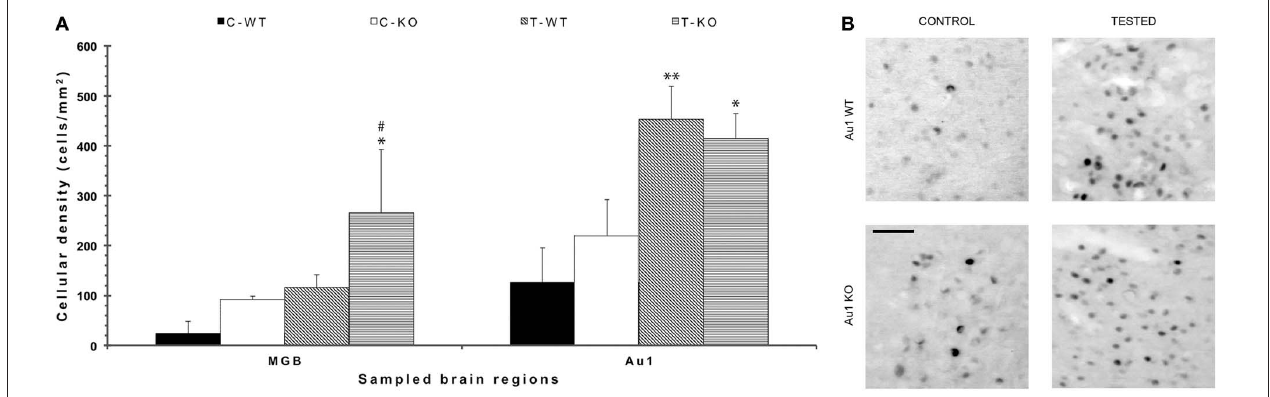
mice with similar treatment (tested or not tested). Three-way ANOVA followed by LSD test. (B) Photomicrographs of FosB/ (cid:2) FosB-immunopositive cell nuclei in Au1. Scale bar: 25 μ m. C-WT, WT mice not exposed to auditory stimulus; T-WT, WT mice exposed to the audiogenic test; C-KO, Fmr1 KO mice not exposed to auditory stimulus; T-KO, Fmr1 KO mice tested; MGB, medial geniculate body; Au1, primary acoustic cortex.